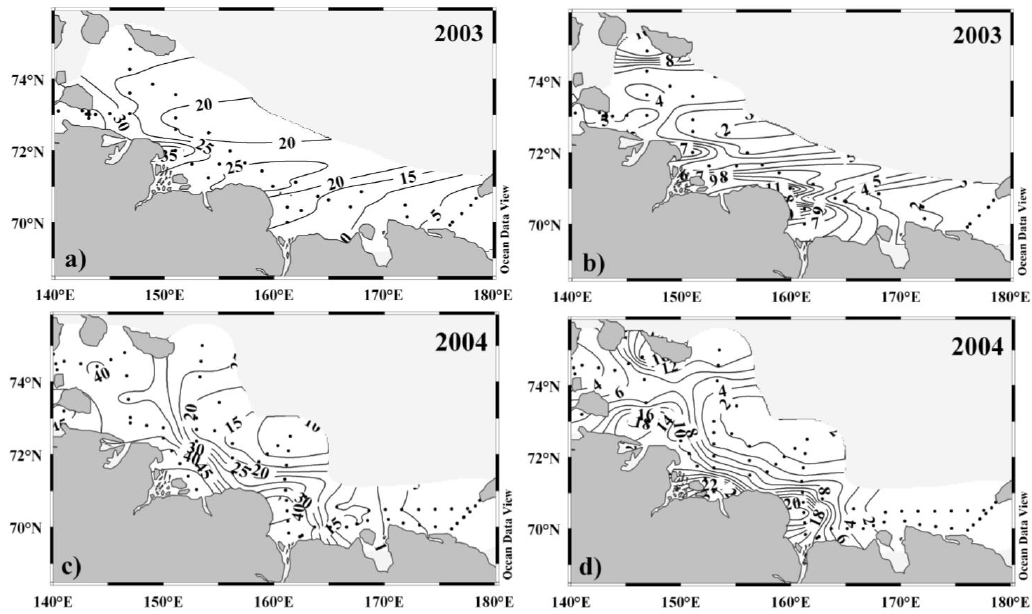
Fig. 11. Spatial distributions of surface water CDOM (µgl − 1 ) (a, c) and SPM (mgl − 1 ) (b, d) over the ESS shelf during the 2003 and 2004